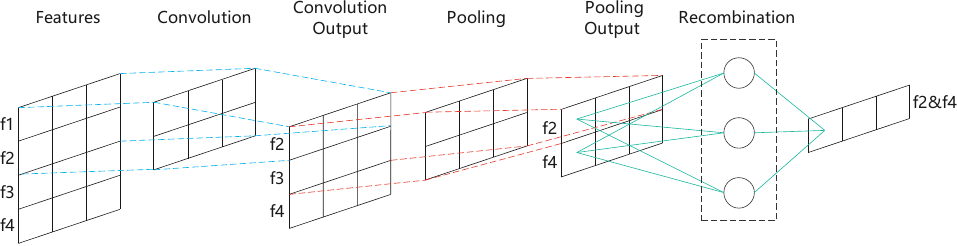
Figure 3. CNN-based feature